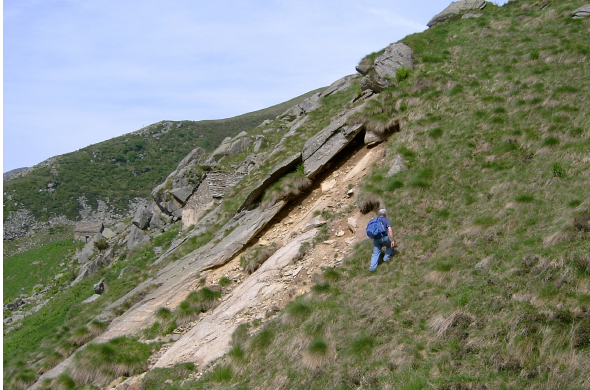
Figure 5. Right slope of a major catchment in the Orco Valley, near the stream head: a rock fall/soil slip process triggered by the ex- treme rainfall event of October 2000. The matrix-dominated nature of the materials is noteworthy and is connected to weathering prod- ucts of the bedrock (photo 11 June 2004).